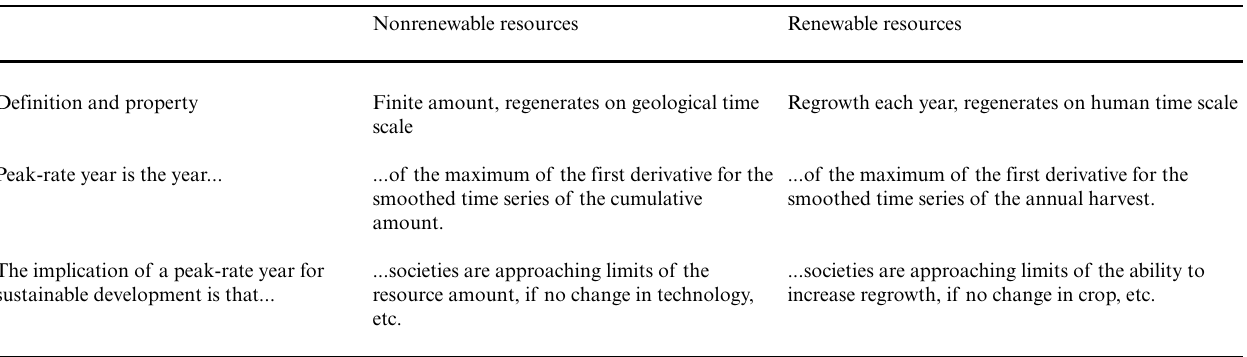
Table 1 . Definition of the peak-rate year by category of resources. Nonrenewable resources Renewable